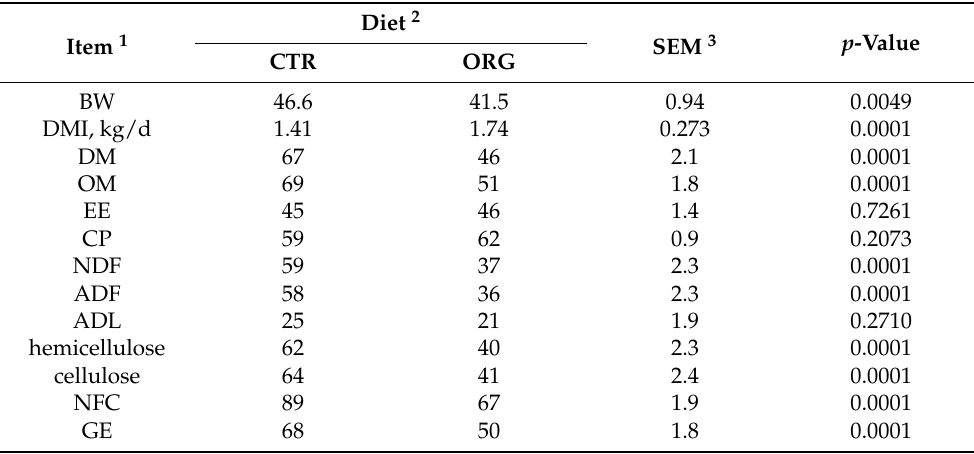
Table 2. Body weight, feed intake, and apparent total tract digestibility (% of DM) of Murciano- Granadina dried goats ( n = 10) by the type of diet.